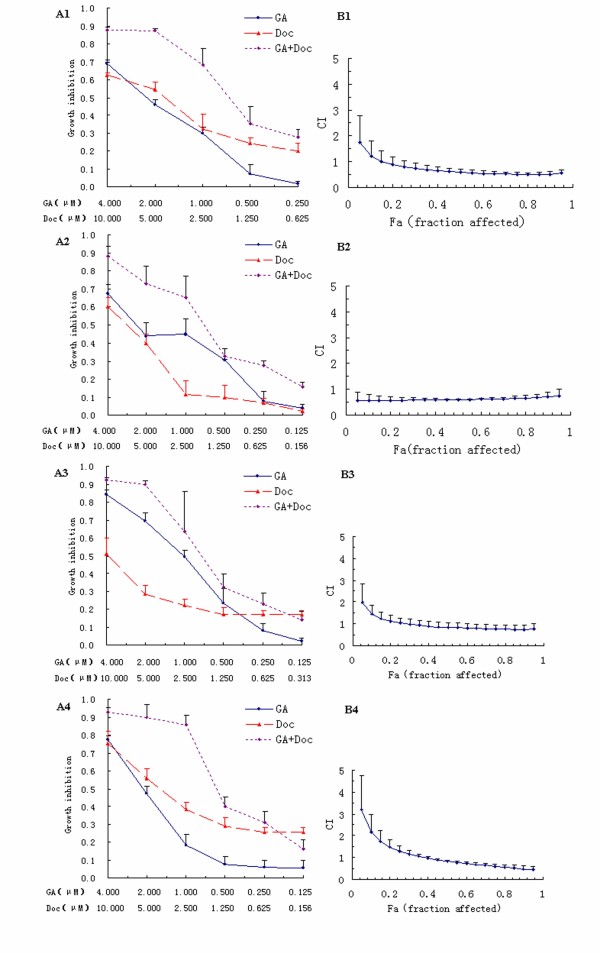
Synergistic effects of GA and Doc on gastrointestinal cancer cells. (A1-4): Dose–response curves for BGC-823 (A1), MKN-28 (A2), LOVO (A3) and SW116 (A4) cells. (B1-4): CI values at different levels of growth inhibitory effect (the fraction of cells affected, Fa) for BGC-823 (B1), MKN28 (B2), LOVO (B3) and SW116 (B4) cells.